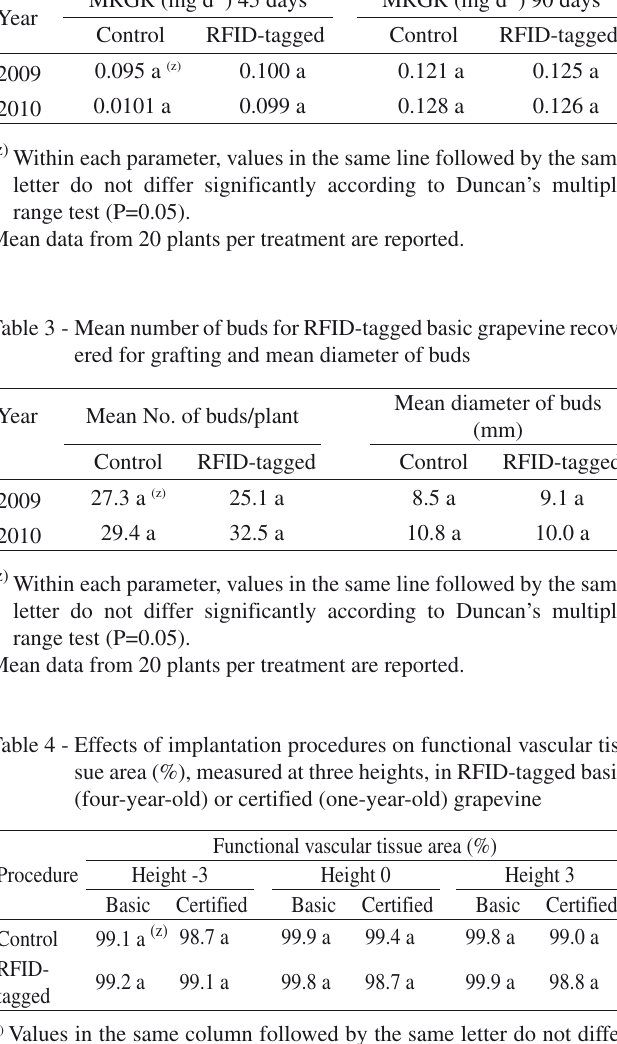
Table 2 - Growth of branches of RFID-tagged basic grapevine ex- pressed as mean relative growth rate (MRGR, mg d -1 ) with one sampling period of 45 or 90 days, calculated from when